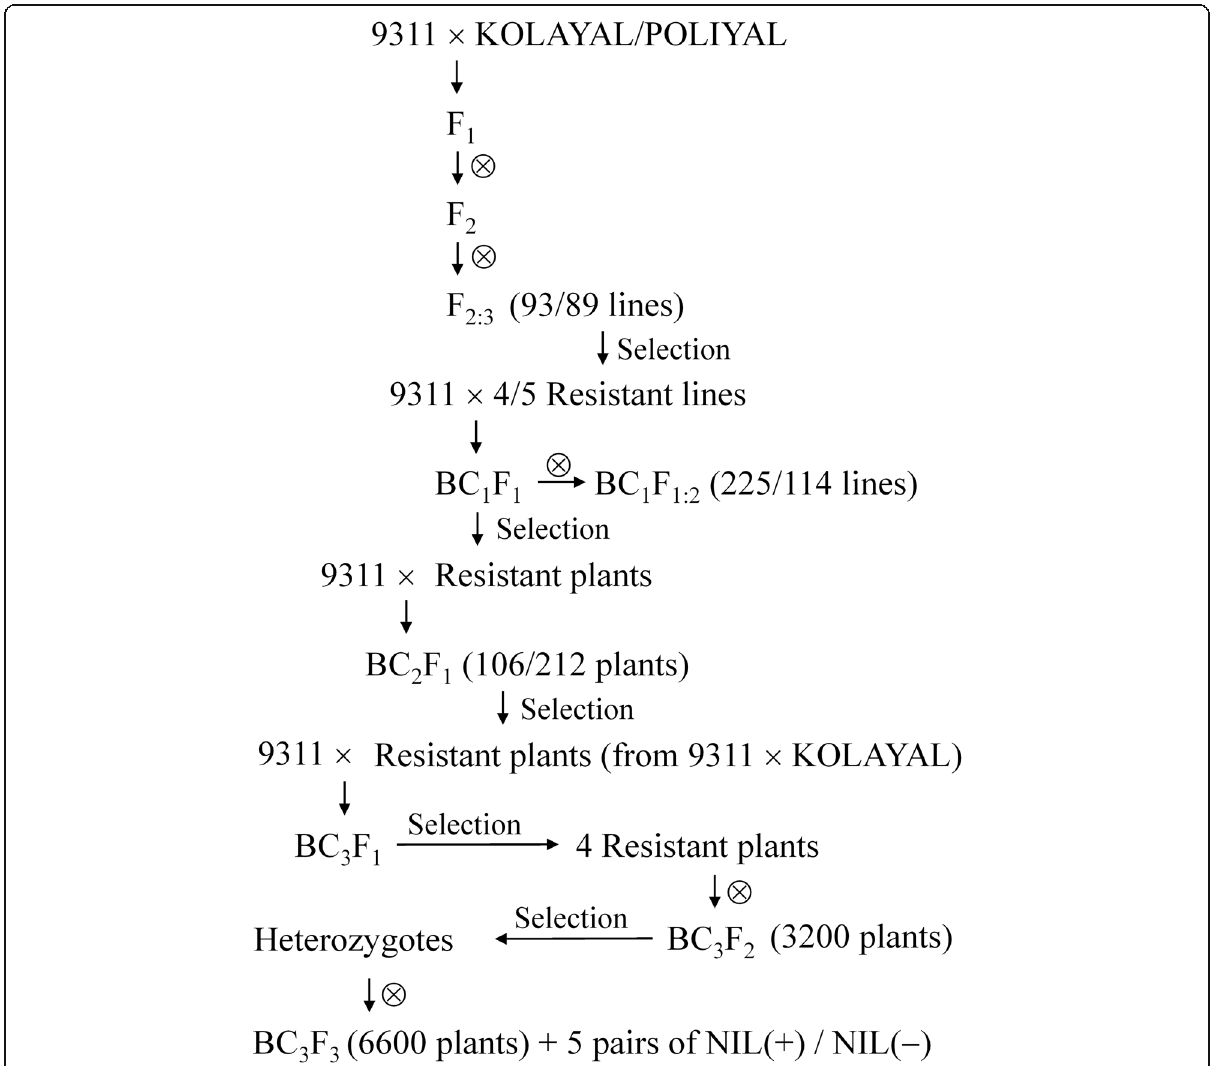
Fig. 8 Procedure of creating experimental populations or lines used in this study. NIL(+)/NIL( − ), near-isogenic lines with 9311 background carrying the BPH resistant/susceptible allele. Both target gene and genetic background were selected. Target gene was selected according to resistance phenotype or flanking markers. Background was selected according to phenotypes of morphological